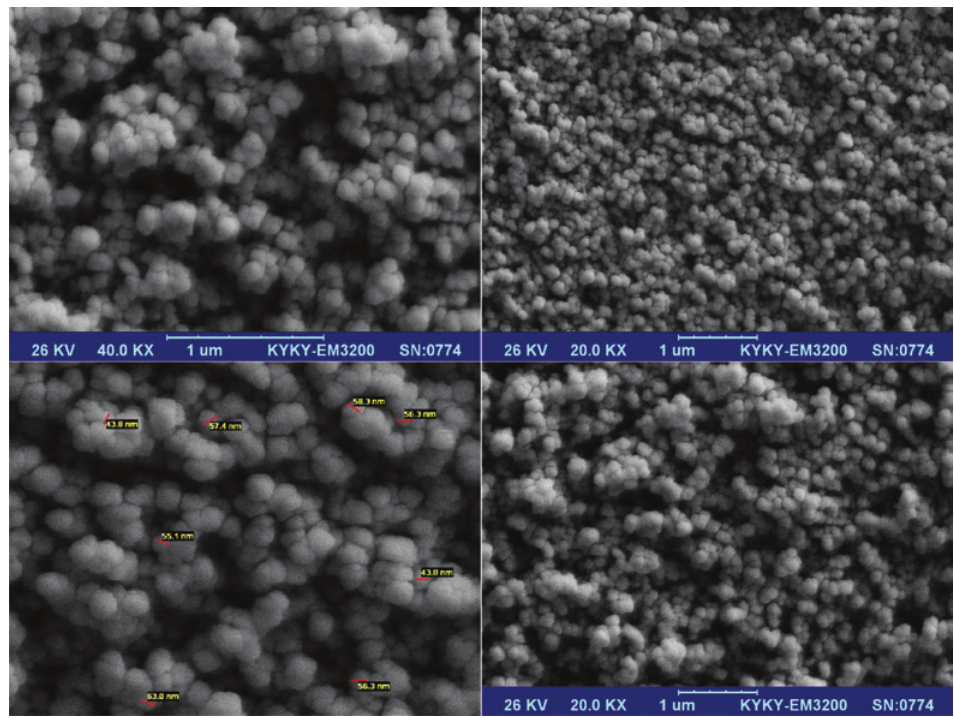
Figure 9: The SEM images of the TiO